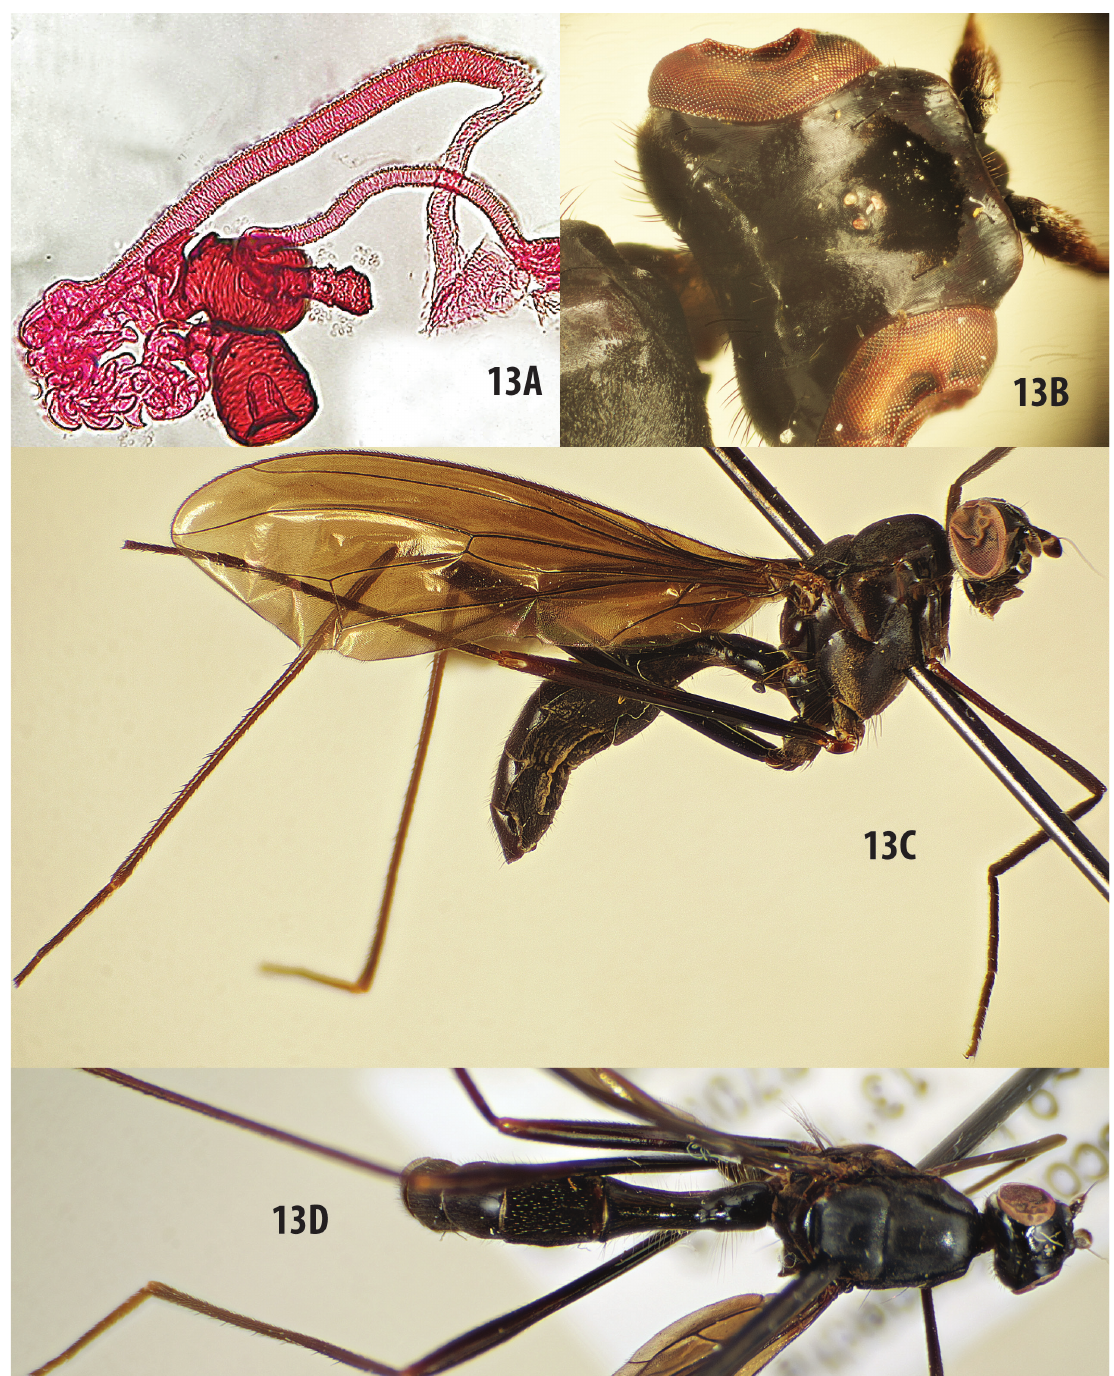
Fig. 13. Mesoconius noteques sp. nov., ♀♀. A . Spermathecae and associated structures. B . Head. C . Habitus, lateral view. D . Body, dorsal